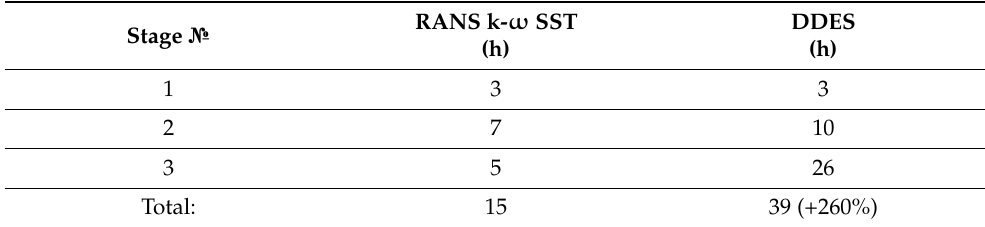
Table 3. Reynolds-averaged Navier–Stokes and Delayed Detached Eddy Simulation time costs single